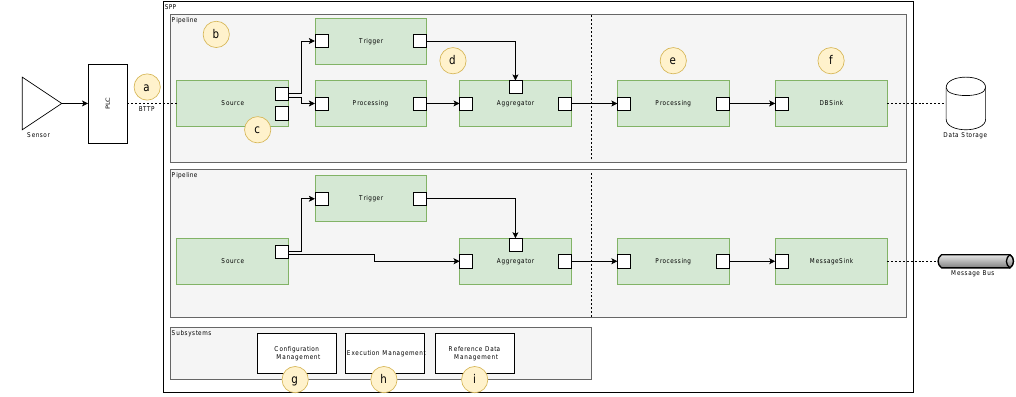
Figure 8. Schematic Overview of the sensor processing pipeline